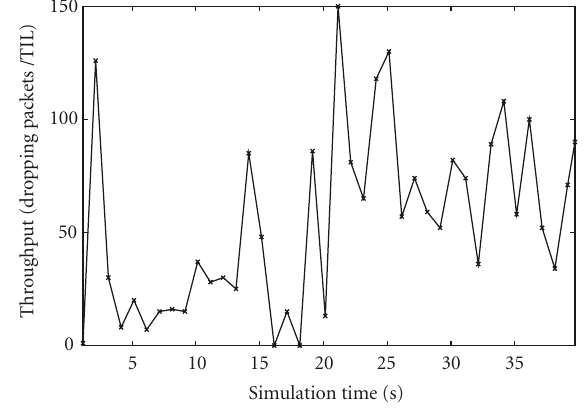
Figure 14: Dropping packets ( N = 25, G = 4, nodes speed = 10 m/s).